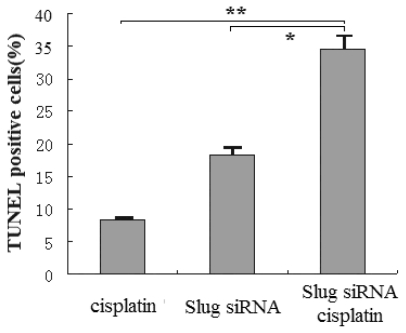
TUNEL staining was performed to assess the potential cooperation of Slug silencing and cisplatin treatment in inducing apoptosis in QBC939 cells. Green nuclear staining indicates apoptotic cells. The percentage of TUNEL-positive cells was quantified. Columns and bars represent mean and standard deviation of three independent determinations, respectively. Significant differences between the controls (mock) and the Slug siRNA groups are indicated by *P < 0.05, **P < 0.01.